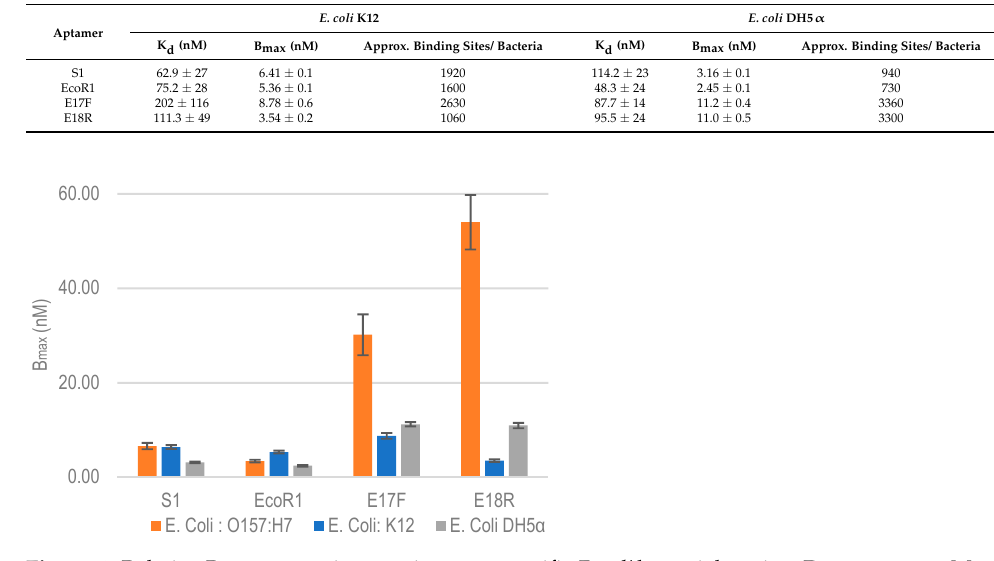
Figure 4. Relative B max comparison against non-specific E. coli bacterial strains. Data represent Mean ± SD of 3 independent experiments.